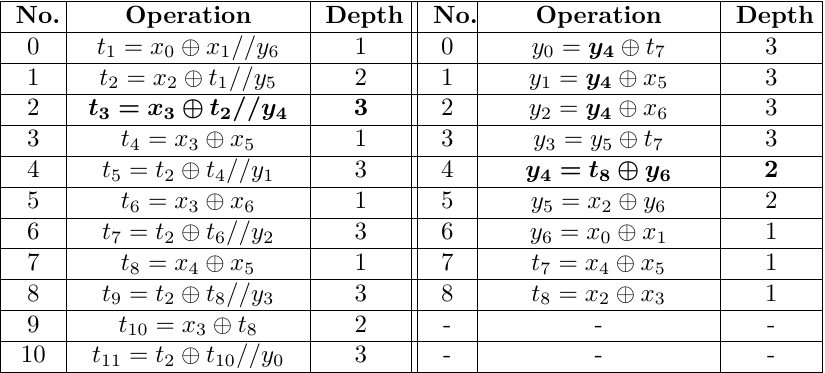
Table 1: The implementations of M P (left: forward algorithm; right: backward algorithm). No.